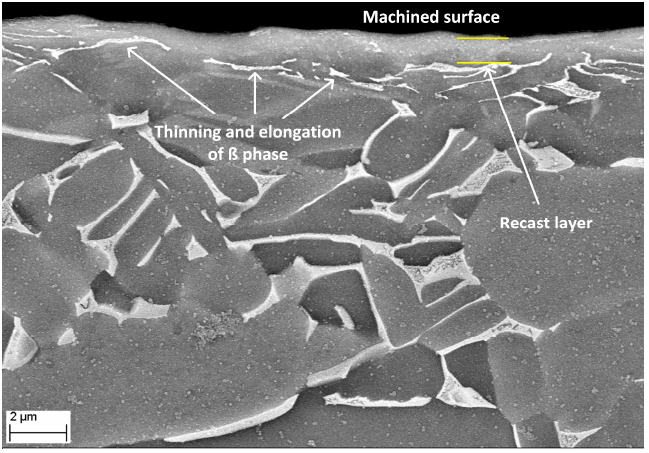
Figure 9. SEM image of thinning and elongation of ß phase (conventional system, 95 m/min cutting speed and 0.1 mm/rev feed rate).